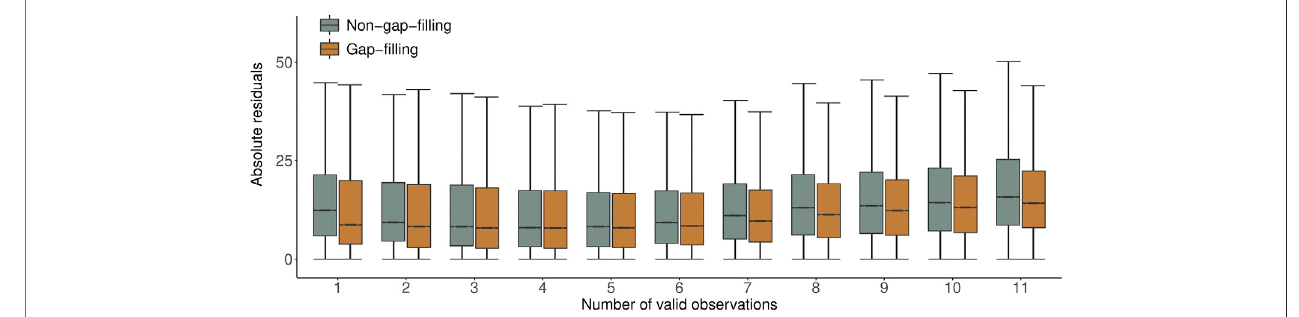
FIGURE 6 | Dependence of absolute residuals on the number of observations for spectral-temporal metrics (STMs). The x -axis is the number of the valid observations of any one pixel through the time series, and y -axis is the absolute residuals. The gap- fi lling method was MOPSTM.